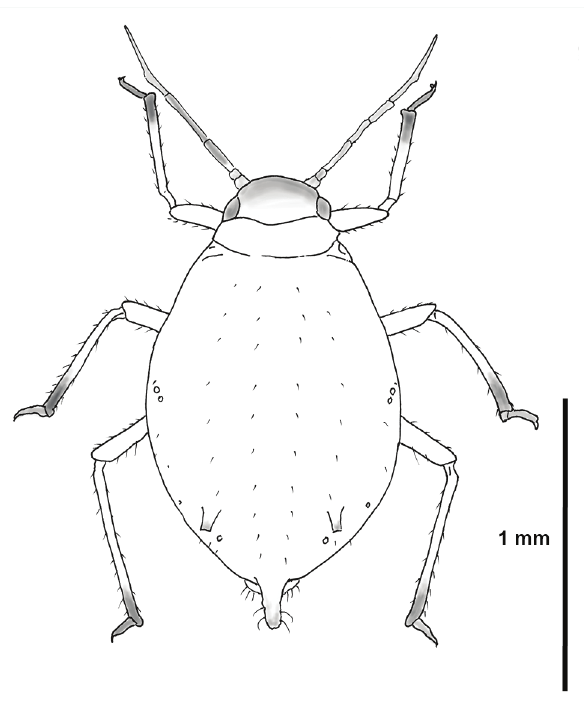
Fig. 23. Aphis equiseticola Ossiannilsson, 1964. Aptera (redrawn after heie